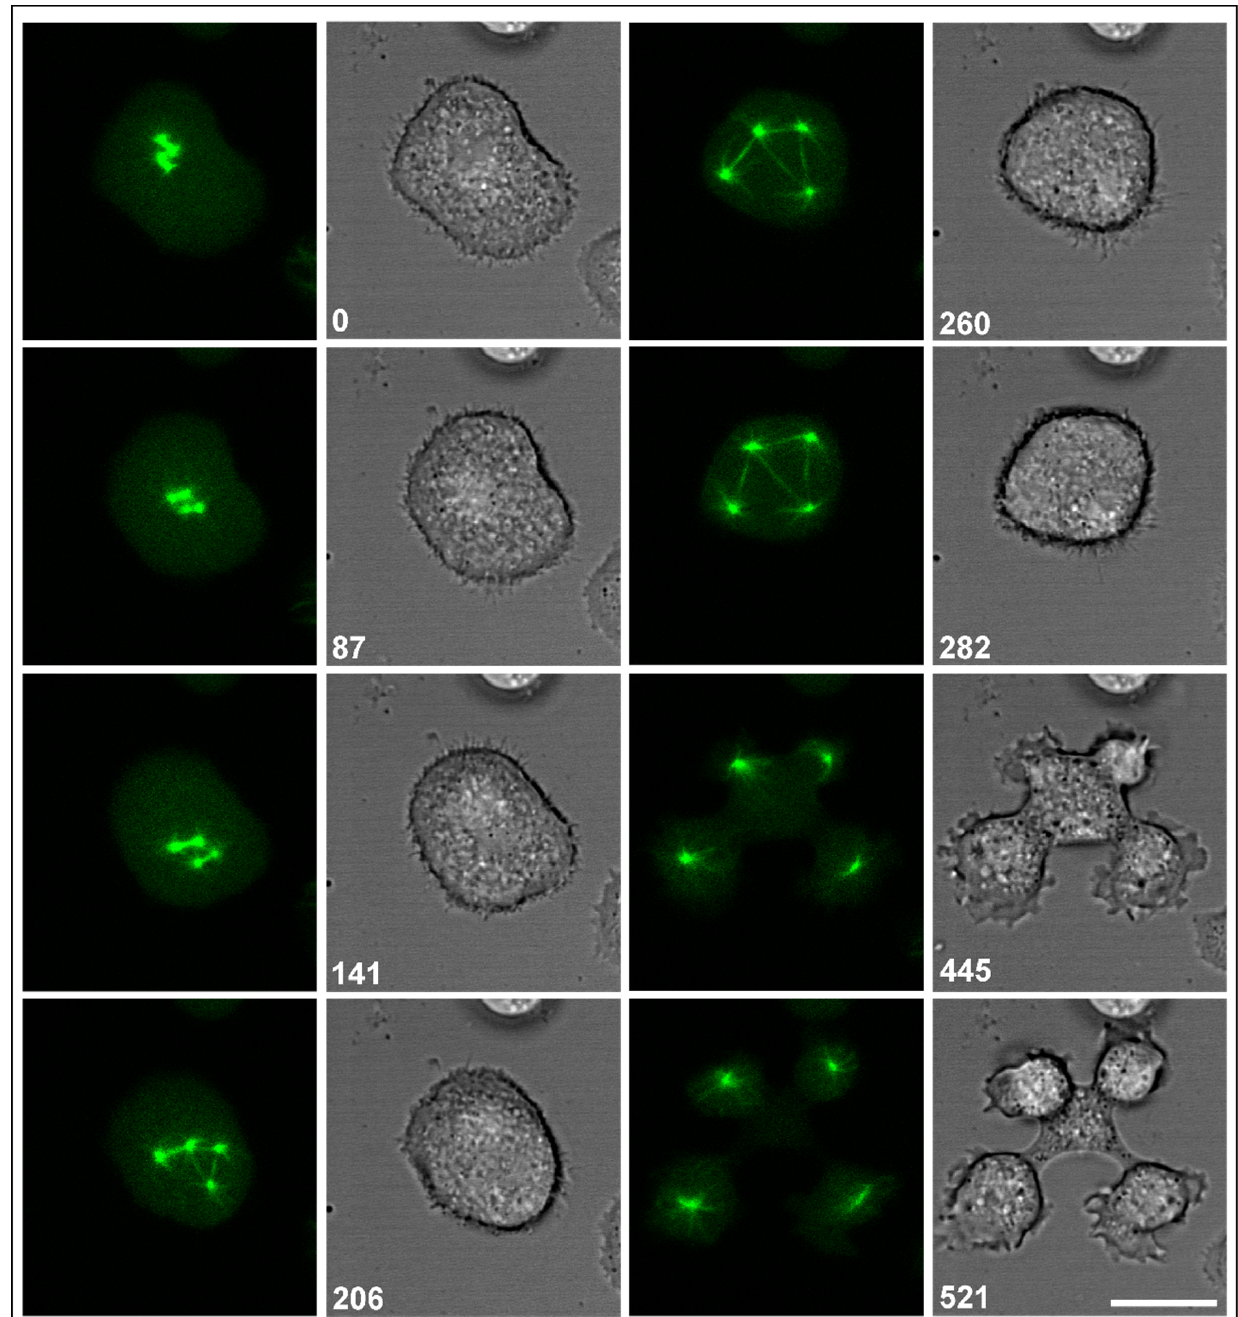
Figure 3. Multipolar centrosomes connected by spindles. The RacB-null cell expressed GFP- α -tubulin ( left panels), showing the centrosomes (0-s and 87-s frames) and elongating spindles (141-s to 282-s frames). In parallel, cell shapes are displayed in confocal bright-field images ( right panels). The cell divided regularly into four daughter cells (445-s and 521-s frames). Time is indicated in seconds. Bar, 10 µm.